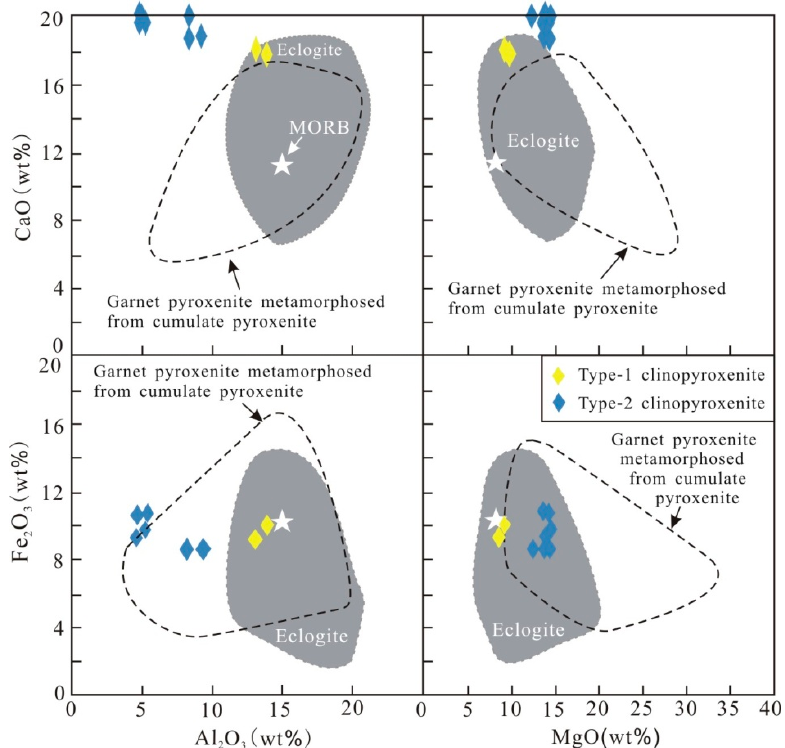
Figure 9. Ca-Fe-Al-Mg variation in eclogite and garnet pyroxenite metamorphosed from cumulate pyroxenite [51]. Average composition of MORB is based on White and Klein [52].